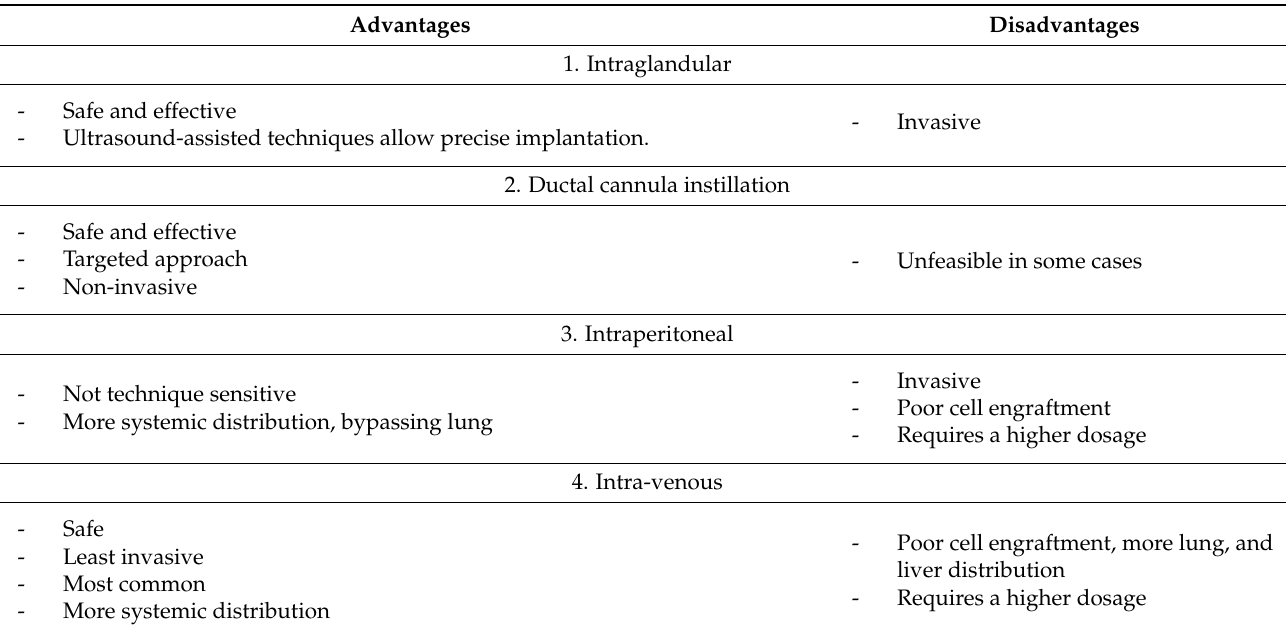
Table 3. Routes of administration of stem cells and their products to